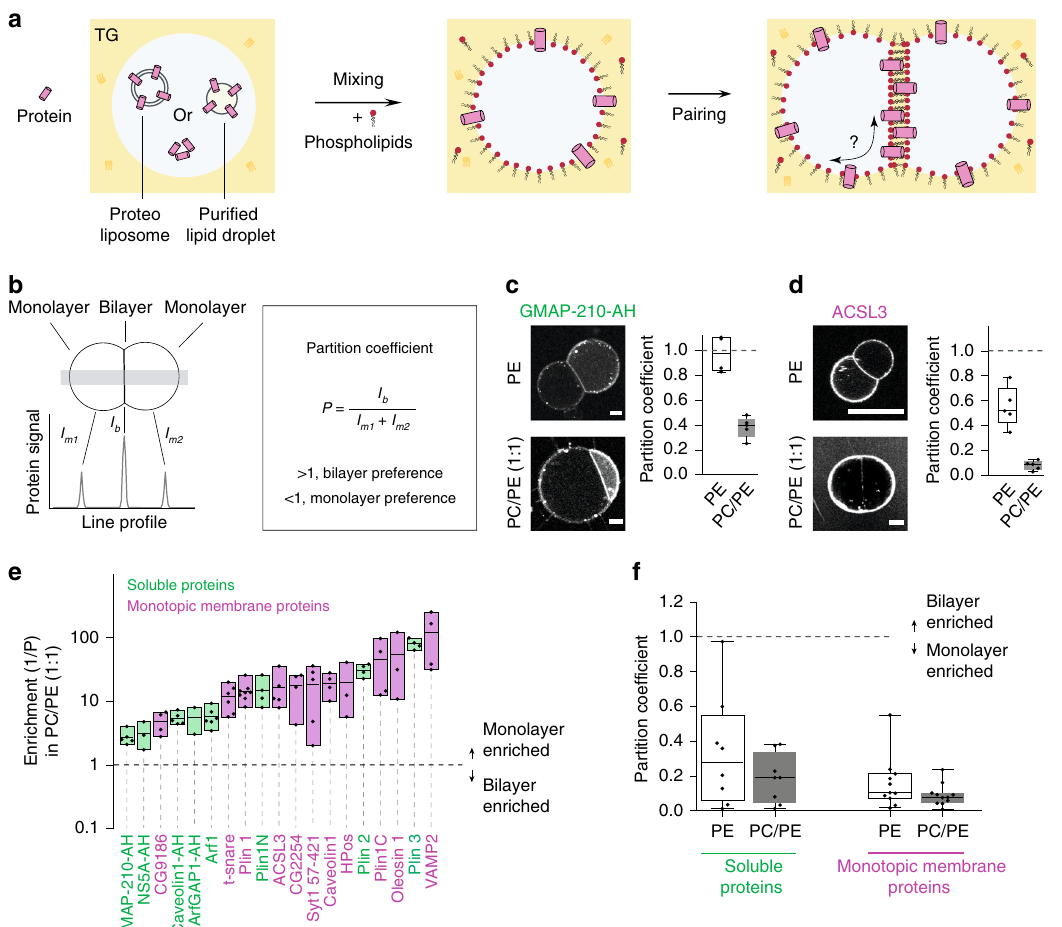
Fig. 2 Partitioning of hydrophobic and amphipathic helix-containing proteins to droplet interface bilayers. a Formation of protein-containing DIBs: soluble protein, proteoliposome, or puri fi ed LDs are added to the buffer droplet (left). Mixing the droplet in a TG-containing phospholipids solution allows the relocalization of proteins to the buffer droplet interface (middle). When two drops come close together, their monolayers zip to form a bilayer. The proteins are thus offered to relocalize to the bilayer (right). b Protein distribution between the bilayer and the monolayer is determined by the partition coef fi cient P, which is the protein signal at the bilayer divided by sum of its signals at the monolayers. When a protein partitions preferentially to the bilayer, p > 1; if preference is for the monolayer then p < 1. c , d Distribution of GMAP-210-AH (soluble protein) and ACSL3 (monotopic membrane protein) respectively, in DOPE or DOPC/DOPE (1:1) DIBs. Scale bar: 20 µ m. The partition coef fi cient is represented for each condition as box-plots from n = 5 independent measurements (excepted for GMAP-210-AH in PE, n = 4). e Enrichment parameter in DOPC/DOPE (1:1) membranes for AH- (green) and HD- (pink) containing proteins, shown as fl oating bars (bar limits, min to max values; central line, mean), 2 ≤ n ≤ 8 independent measurements were done for each protein. HD-containing proteins coming from LDs are Plin 1, Plin 1C, ACSL3, CG2254, CG9186, Oleosin 1, Caveolin 1, HPos; those coming from proteoliposomes are Syt1 57-421, t-snare, Vamp2; AH-containing proteins coming from LDs are Plin3, Plin2, Plin1N; the other AHs are added soluble. f Average partition coef fi cient of the groups of soluble or monotopic membrane proteins in DOPE or DOPC/DOPE (1:1). Results presented in (Supplementary Fig. S2e) were used to generate ( f ). Box-plots are de fi ned as follow: box limits, upper and lower quartiles; middle line, median; whiskers, minimum and maximum value. In c , d , e , f each point is represented as a black dot. Source data are provided as a Source Data fi